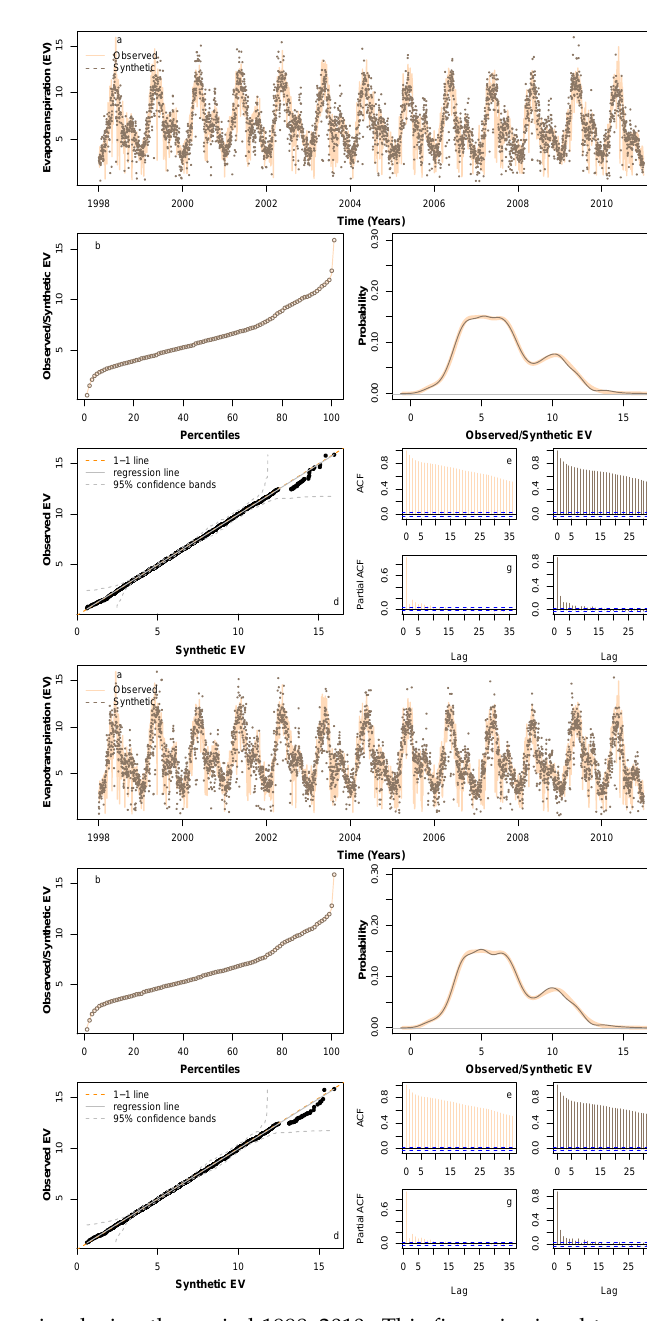
Figure A1. Comparison of four sample synthetic EV time series during the period 1998–2010. This figure is aimed to illustrate the performance of the model for additional four samples and is a cluster of four subfigures that contains 8 subsubfigure each (listed as a – h ) for consistency. See Figure 6 for individual subfigure